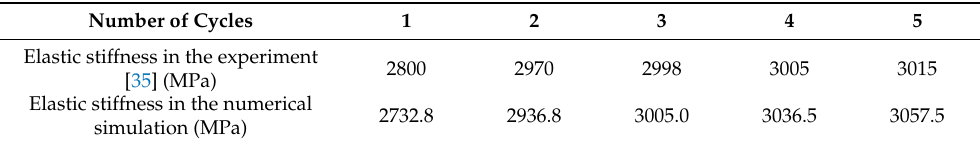
Table 2. Results of the ES of the sample in experiments and model in the numerical simulation, induced by cyclic compressive loading.